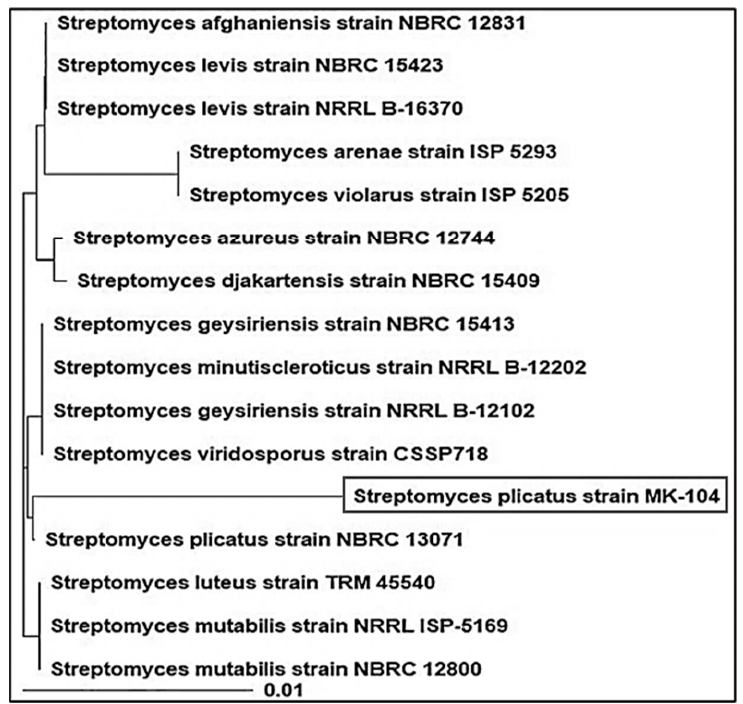
Figure 5. Phylogenetic tree of Streptomyces plicatus MK-104 strain as well as the most genetically similar Streptomyces ‐ type strains.